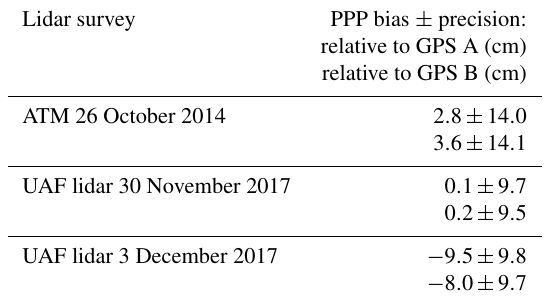
Table 1. Elevation bias and surface measurement precision (cm), relative to ground-based GPS survey data, for ATM and UAF air- borne lidar elevation data. Results are posted as GPS elevation – Lidar elevation